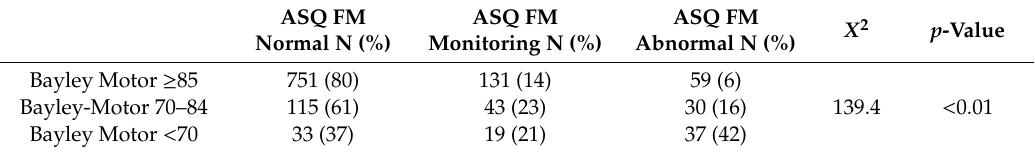
Table 3. Comparison of Bayley-III Motor Composite and ASQ Fine Motor (FM).